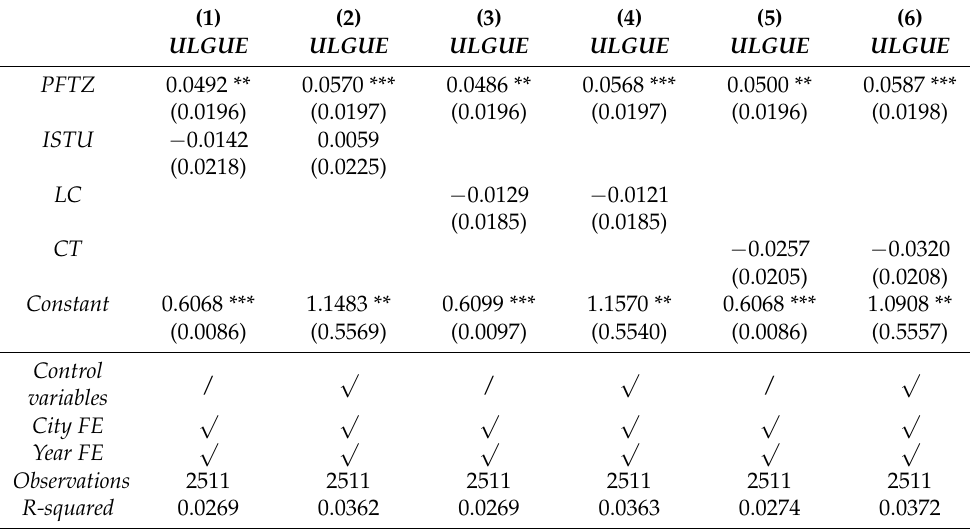
Table 7. Control for other related